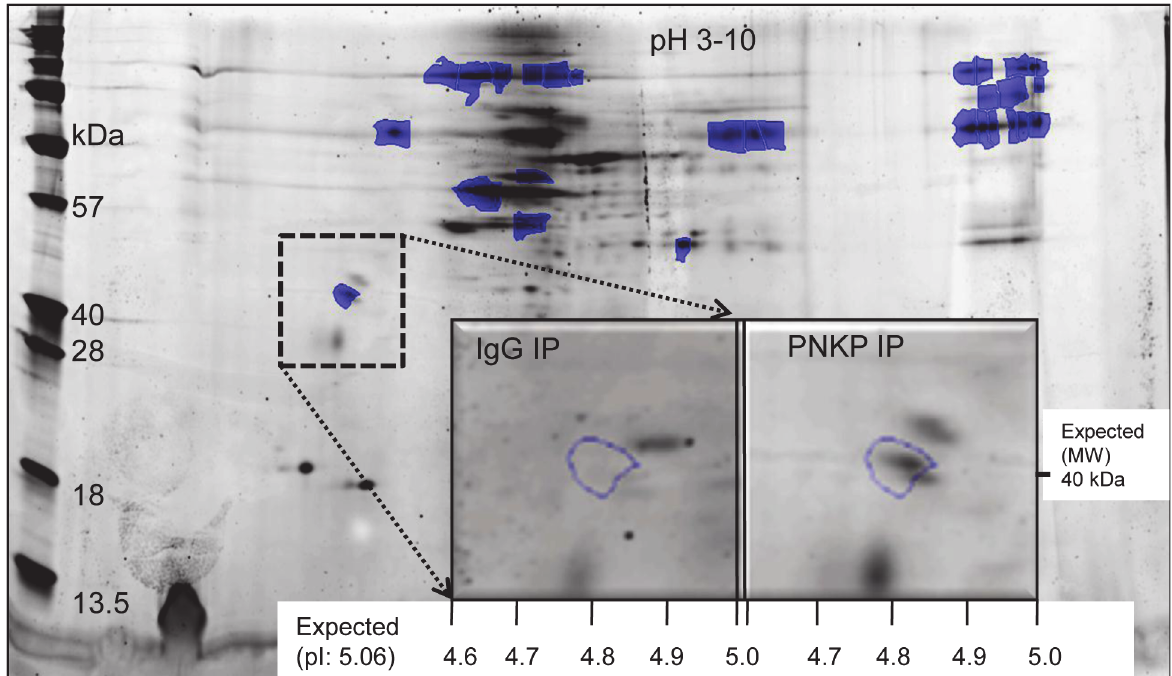
Figure 1. Identification of ATXN3 in the PNKP IP by 2D gel and MALDI-TOF-TOF MS analysis. The spot annotated within the dashed box (absent in the control IP) was identified as human ATXN3 by subsequent MS/MS analysis (S1